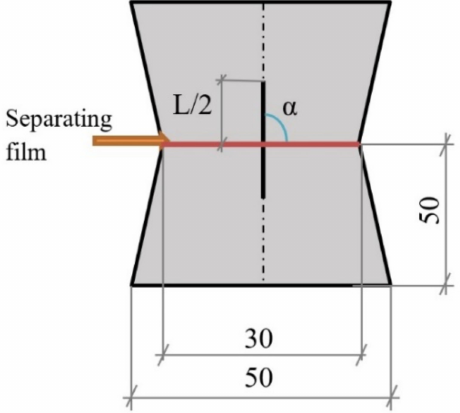
Figure 2. Single fiber pull-out test specimen scheme.